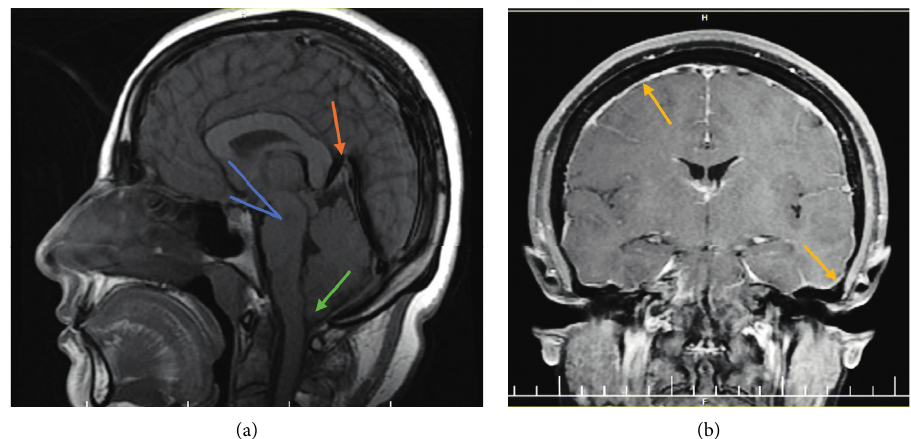
Figure 1: Brain MRI of patient demonstrating (a) cerebellar tonsillar herniation of about 6mm below the foramen magnum (green arrow), closed pons/midbrain angle (blue lines), and venous engorgement (orange arrow) and (b) mild smooth diffuse dural enhancement (yellow